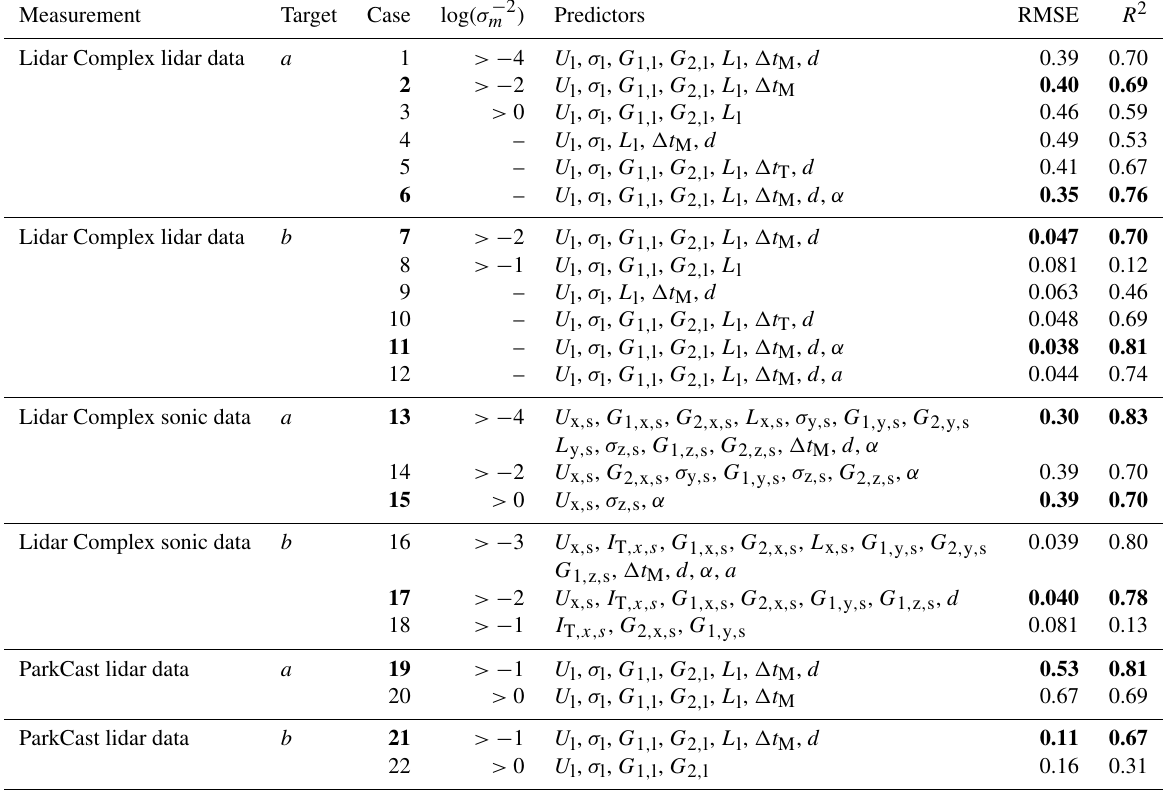
Table 5. Summary of the predictors selected according to different lower limits of log( σ different data availability, and different targets. R 2 and RMSE are obtained from a 5-fold cross-validation of the model trained with the respective combination of predictors. The bold text indicates the recommended predictor